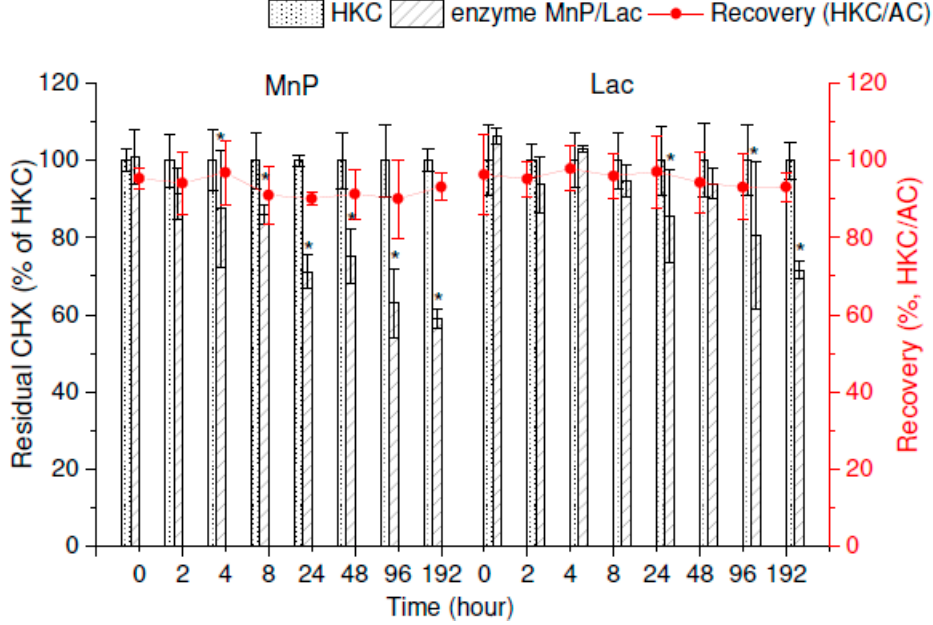
Figure 2. In vitro degradation of chlorhexidine (CHX) in concentrated extracellular liquids of I. lacteus (manganese-dependent peroxidase, MnP) and P. ostreatus (laccase, Lac). Initial concentration of CHX was 5 µg/mL in both experiments. The red line graphs show the recovery of CHX extraction during the experiment expressed as the heat-killed control (HKC) and abiotic control (AC) ratio. Error bars represent standard deviation ( n = 3). The asterisk marks a significant difference between the individual harvesting day and the control group—0 d (post-hoc Dunnett’s Test).